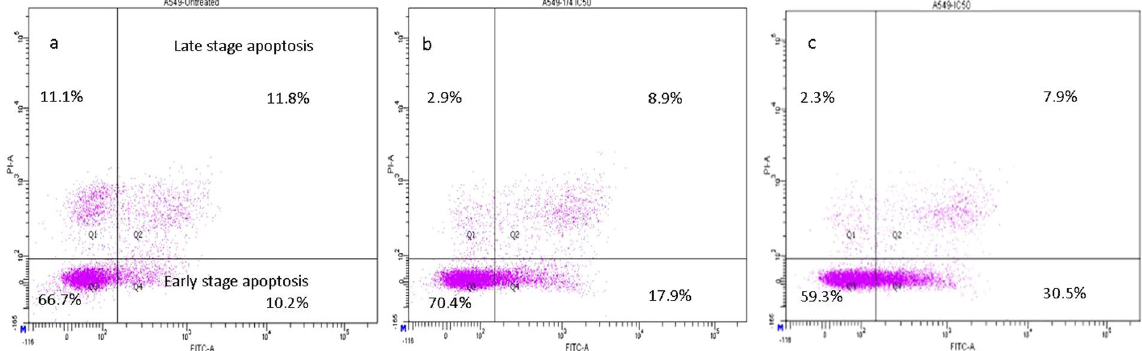
Figure 8. Annexin V/PI assay showing the apoptosis-inducing effect of CPT-CEF. A549 cells were treated with various concentrations of CPT-CEF: ¼ IC 50 (panel b), IC 50 (panel c), or untreated (panel a) for 48 h, and viability was assessed via Annexin V/PI assay and flow cytometry.